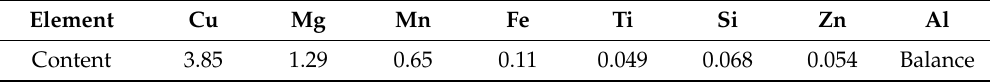
Table 1. Chemical compositions of the D16T aluminum alloy